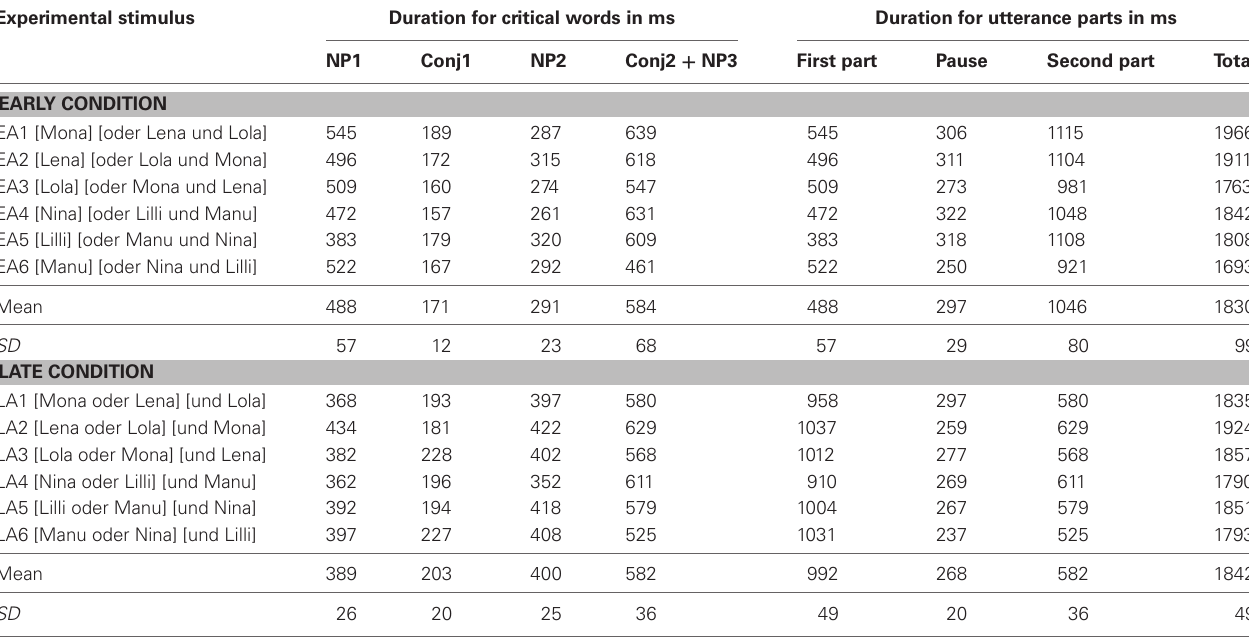
Table 2 | Duration in ms for critical words, pauses and utterance parts (before/after the pause), rounded to the nearest whole number, for each token employed in the EARLY condition (EA1–EA6) and in the LATE condition (LA1–LA6), respectively. Experimental stimulus Duration for critical words in